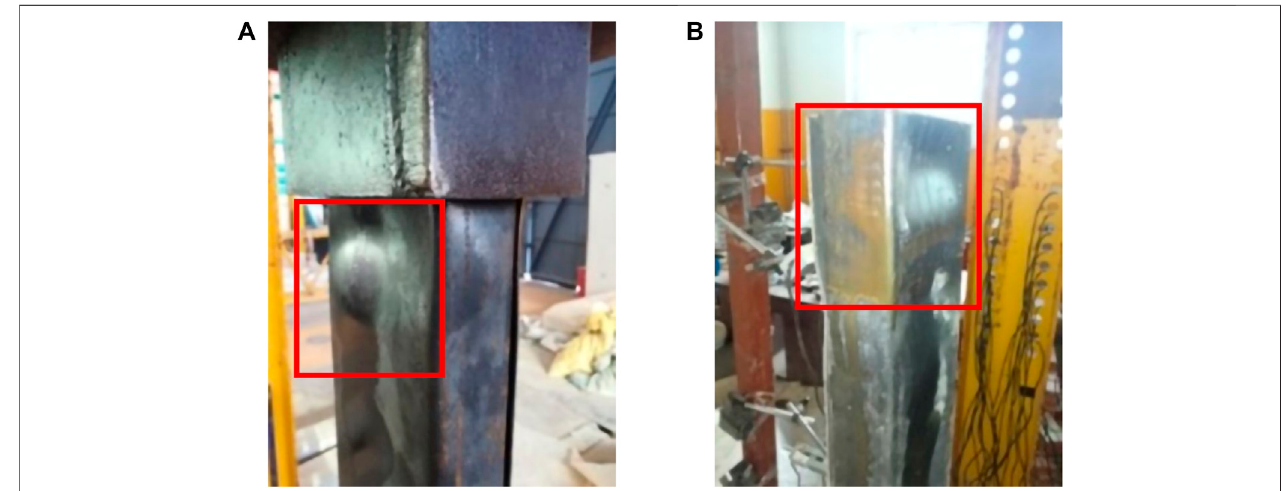
FIGURE 6 | (A) Local buckling of R50-2.2-K. (B) Buckling of the specimen at the end of